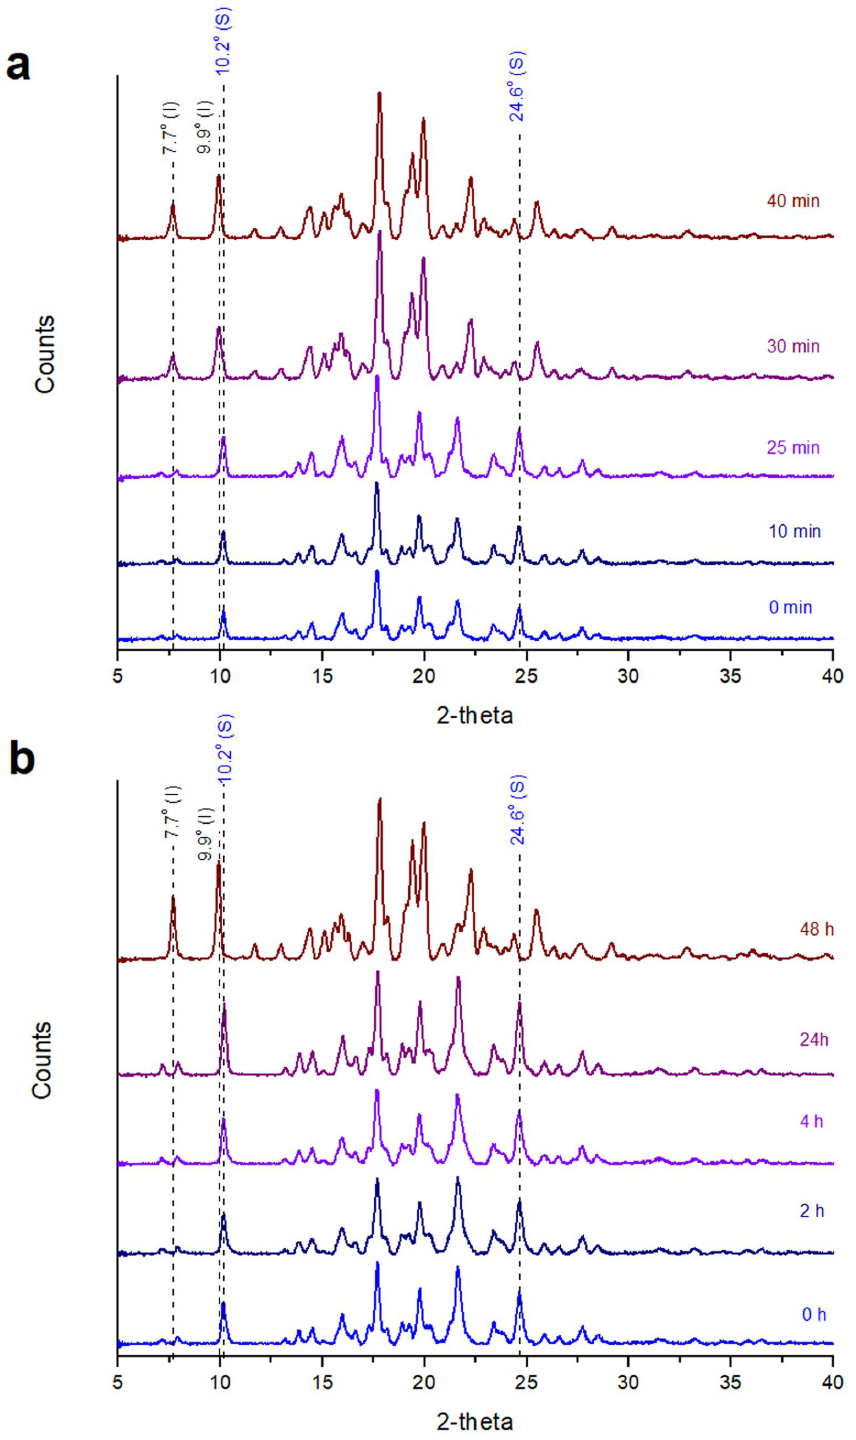
Figure 3. XRPD patterns of posaconazole Form-S left in ambient conditions ( a ) without using a cover; ( b ) using LDPE cling film as a cover (black peak labels: characteristic peaks for posaconazole Form I; blue peak labels: characteristic peaks for posaconazole Form-S).